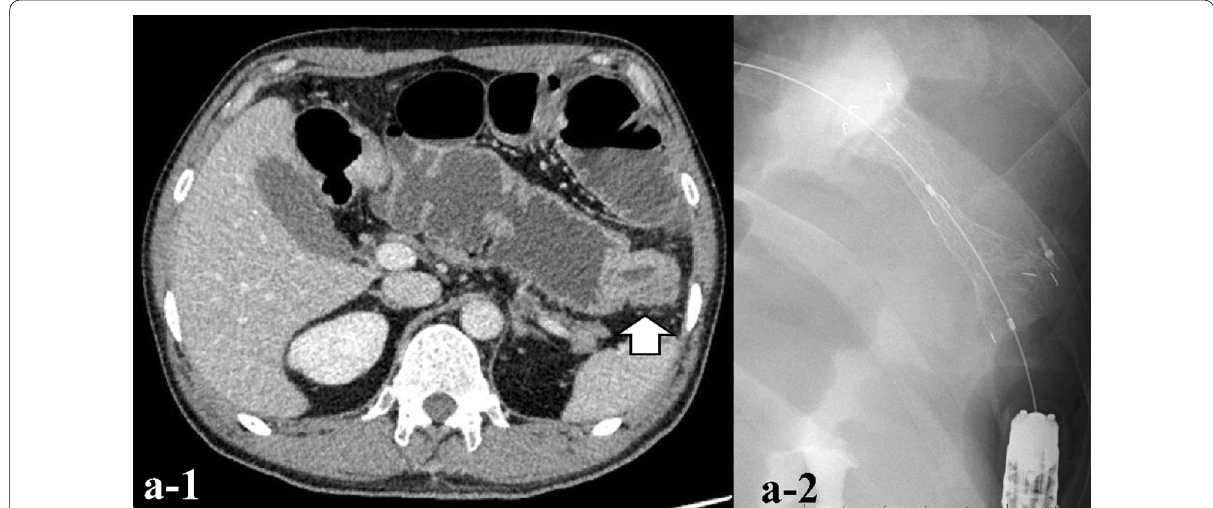
Fig. 1 Abdominal CT and a colon stent. a-1 Contrast-enhanced peripheral wall enhancement (white arrow) was observed in the descending colon and splenic flexure. Dilation of the gastrointestinal tract was also observed. a-2 A colon stent was placed at the same